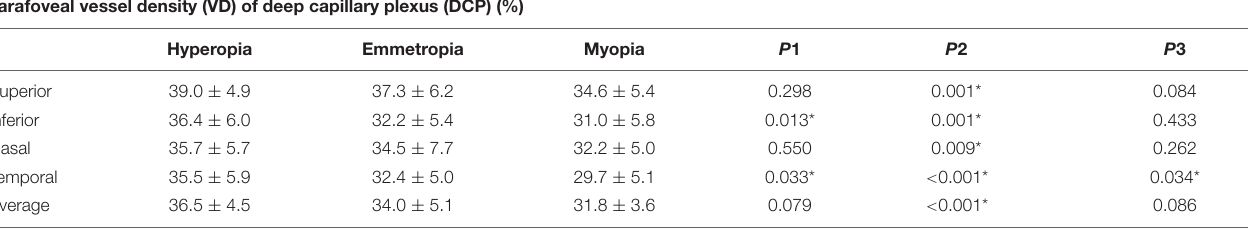
TABLE 2 | The comparisons of parafoveal retinal vessel density among hyperopia, emmetropia, and myopia groups. Parafoveal vessel density (VD) of deep capillary plexus (DCP) (%)